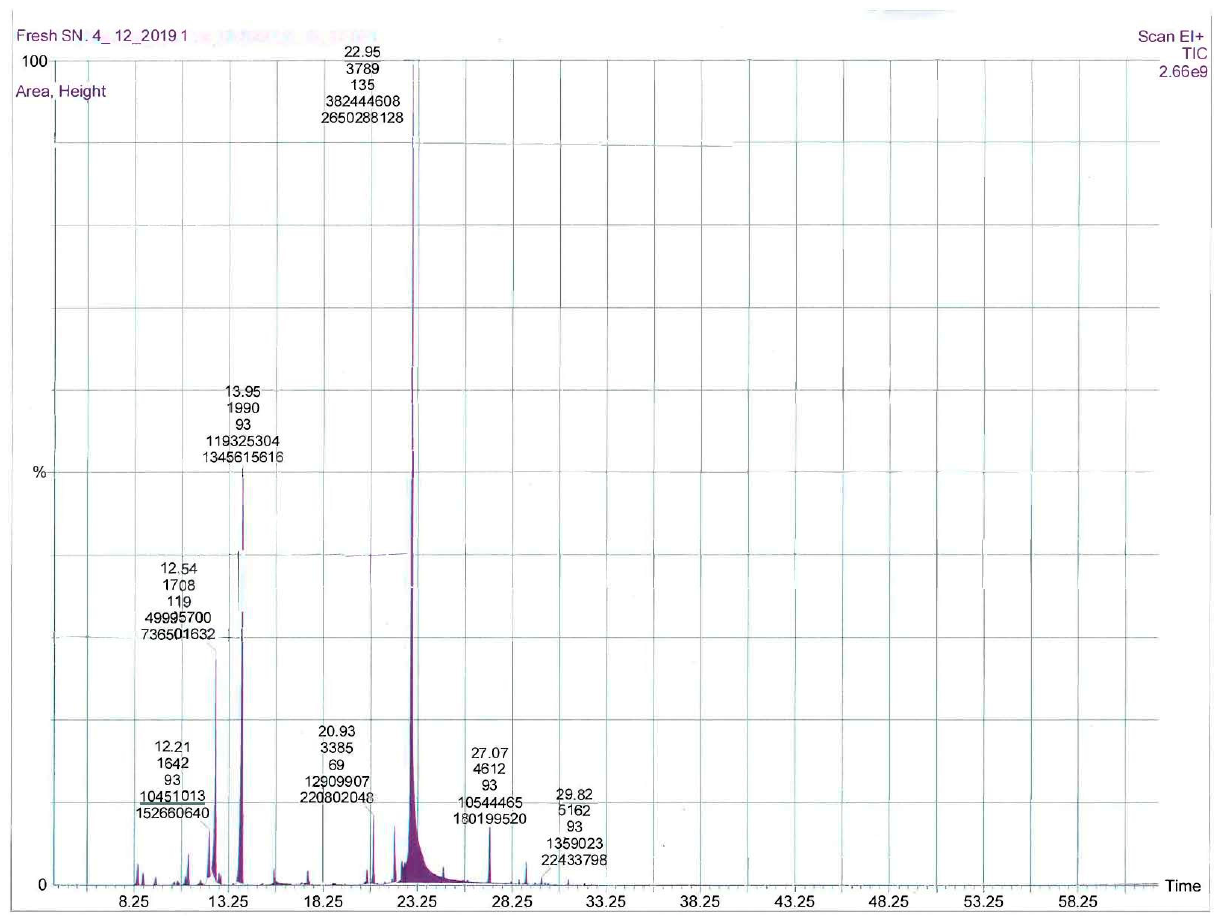
Figure 1. GC-MS chromatogram of the essential oils from fresh S. nabateorum. GC-MS allowed us to identify a total of 42 compounds in the investigated EOs of S. nabateorum , accounting for around 99% as relative to peak area, with thymol (46.07 ± 1.1 and 40.64 ± 1.21%), γ -terpinene (21.15 ± 1.05% and 20.65 ± 1.12%), and p -cymene (15.02 ± 1.02% and 11.51 ± 0.97%) being the main components of the EOs, respectively (Table 1 and Figure 1). Both EOs of S. nabateorum contained a high concentration of phenolic monoterpenes and monoterpenes (around 95%) and a very low concentration of sesquiter- penes. Significant differences were observed when the main components of S. nabateorum were compared to those of previously examined Satureja species. In contrast to other Satureja plants, carvacrol, a constitutional isomer of thymol, was not identified in the EO of S. nabateorum . Carvacrol was found to be the most prevalent component in most Sat- ureja species’ EOs (27.24–88.71%), followed by γ -terpinene (3.18–23.20%) and p -cymene (2.77–13.34%)